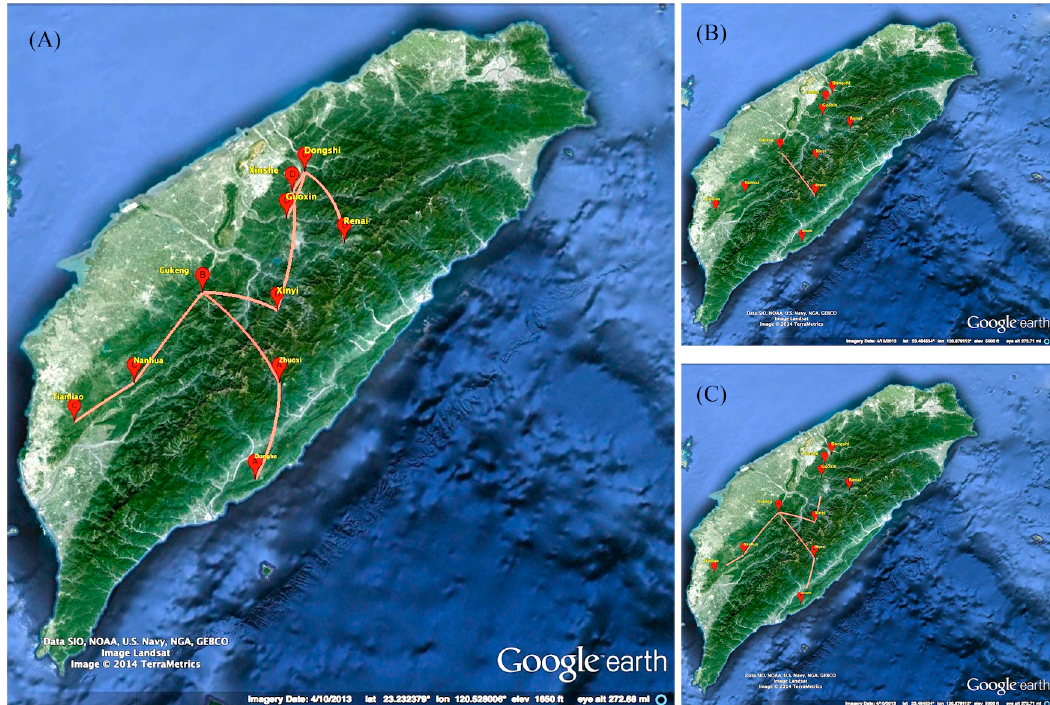
Figure 2. The migrations of temporal dynamics for the rabies virus in the Formosan ferret badger. ( A ) The branches expressed an overview of the spread in Taiwan; ( B ) The first stage was spreading from east to the west side; and ( C ) The second stage was spreading over into two branches and moved to southern and central regions. Map data: Google earth and TerraMetrics.